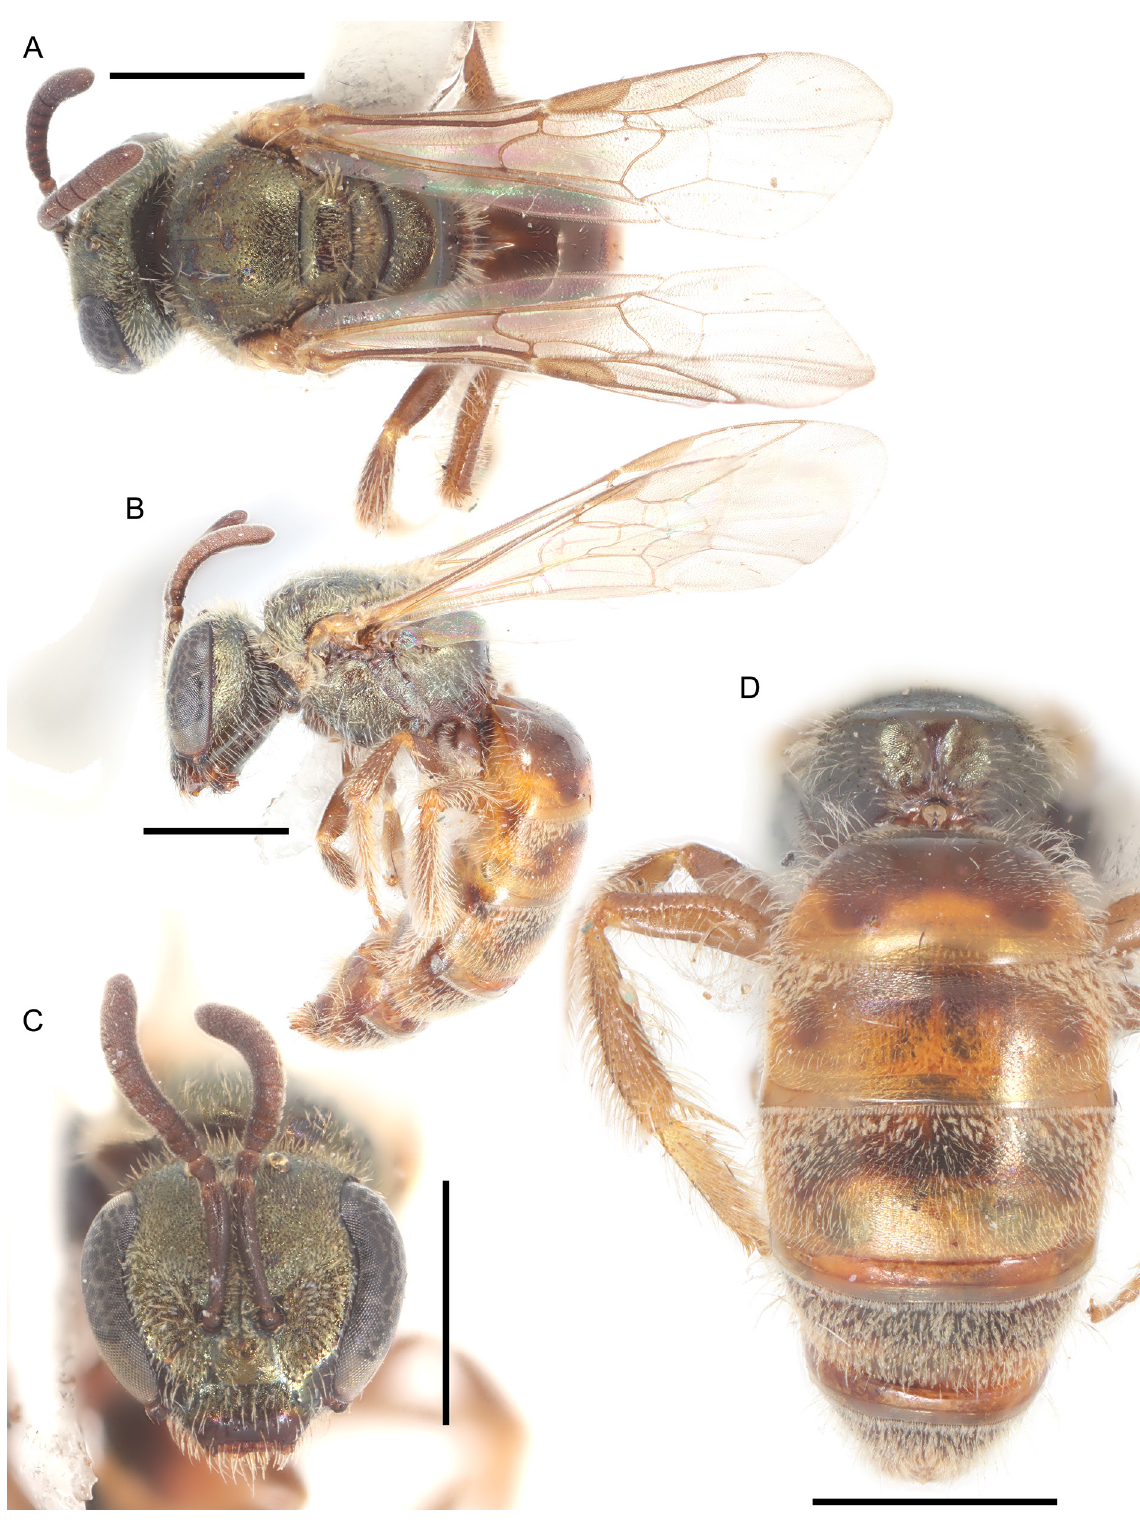
Fig. 85. Lasioglossum ( D. ) torrens sp. nov., ♀. A . Dorsal habitus. B . Lateral habitus. C . Face. D . Propodeum and metasoma. Scale bars: 1